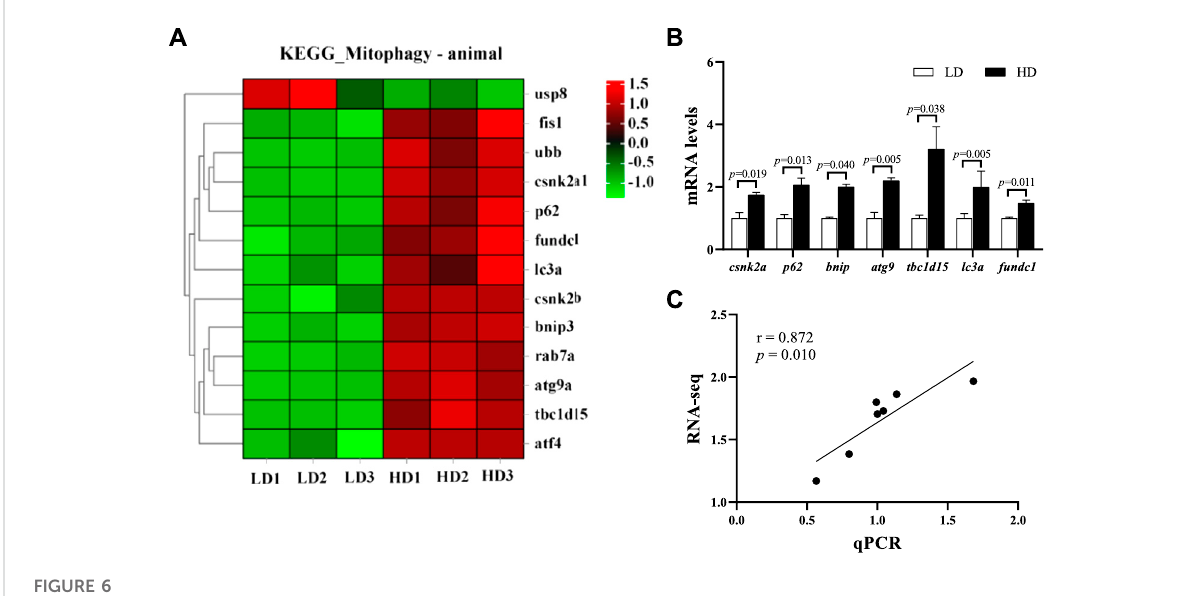
FIGURE 6 Changes of mitophagy pathway in the hepatopancreas of C. quadricarinatus between the LD group and the HD group. (A) DEGs enriched in mitophagy pathway. (B) Mitophagy-related gene expression measured by qPCR, values are presented as means ± SE ( n = 3) (C) The correlation between the qPCR data and RNA-seq data.